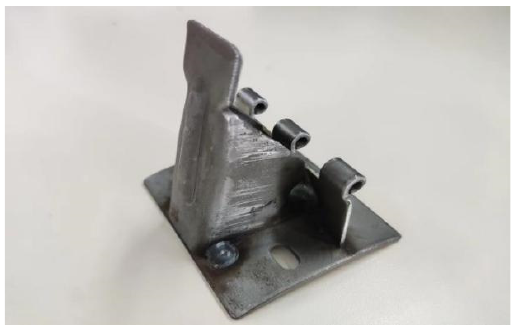
Figure 19. HMI. Figure 19. HMI.